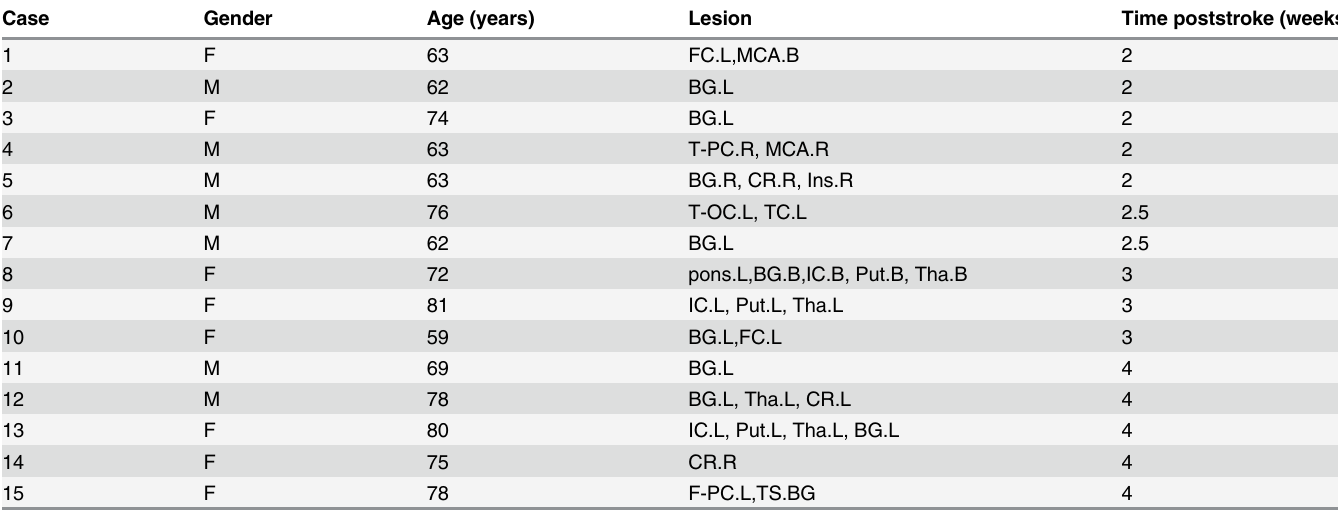
Table 1. Clinical and demographic data of 15 patients with stroke enrolled in this